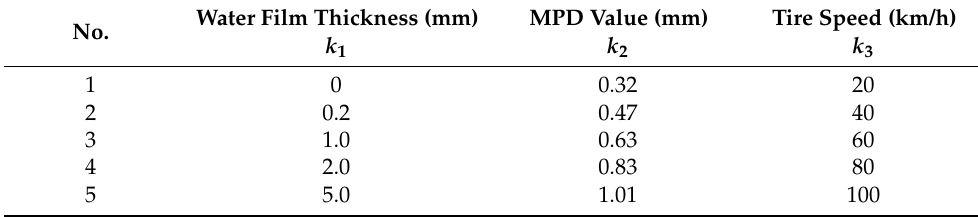
Table 5. Levels of influence factors in a wet road